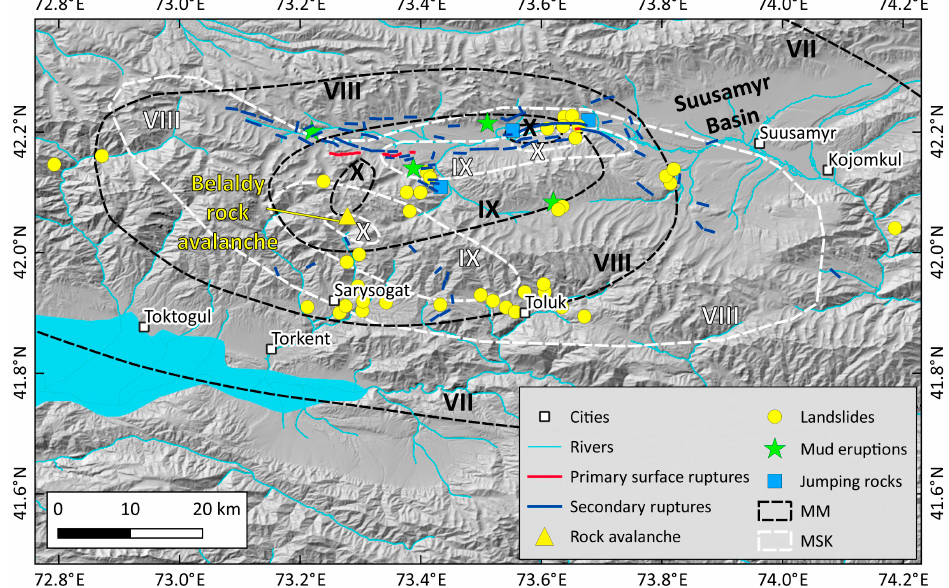
Figure 2. Earthquake environmental effects (EEEs) of the 1992 Suusamyr Earthquake. Primary surface ruptures are from References [6,7,21]. Secondary ruptures are from References [21,23].